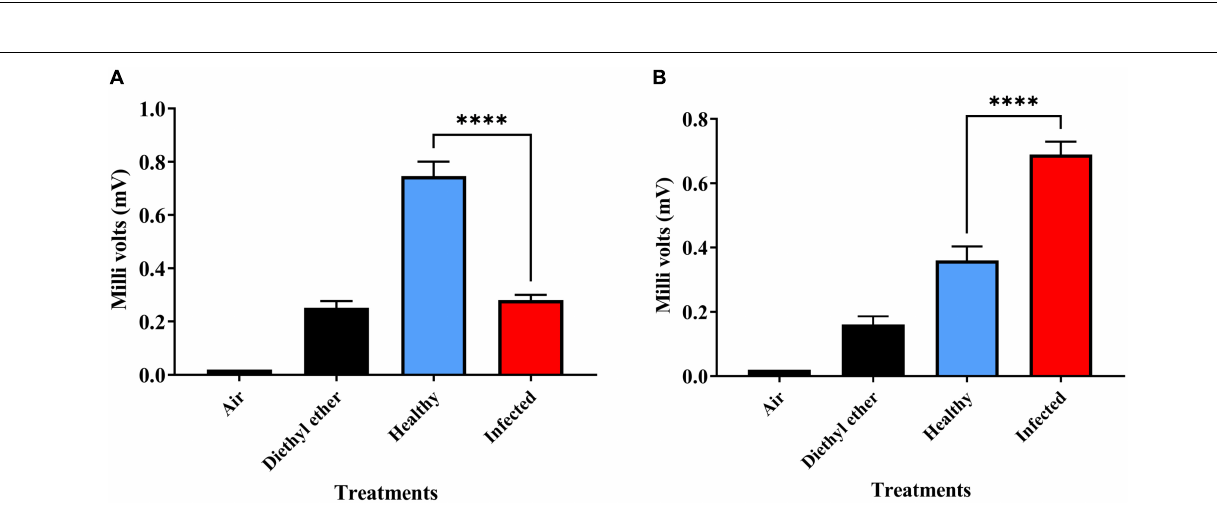
Frontiers in Ecology and Evolution |